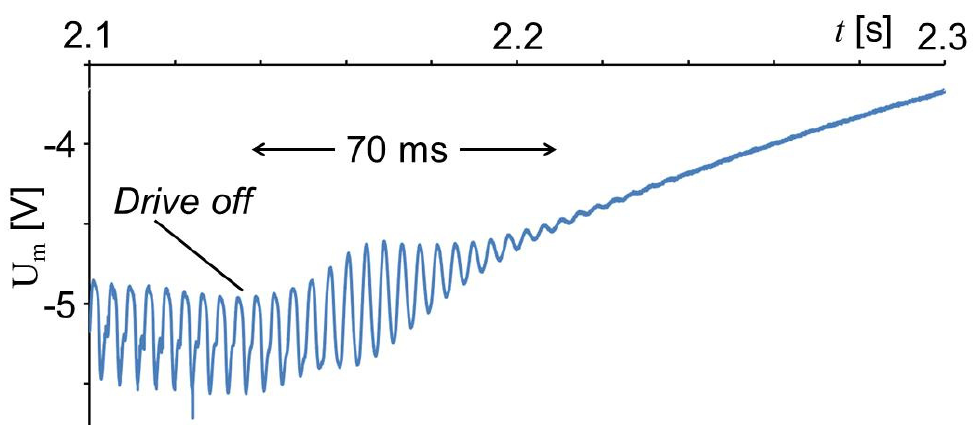
Figure 14. Stopping range of the signal shown in Figure 10.